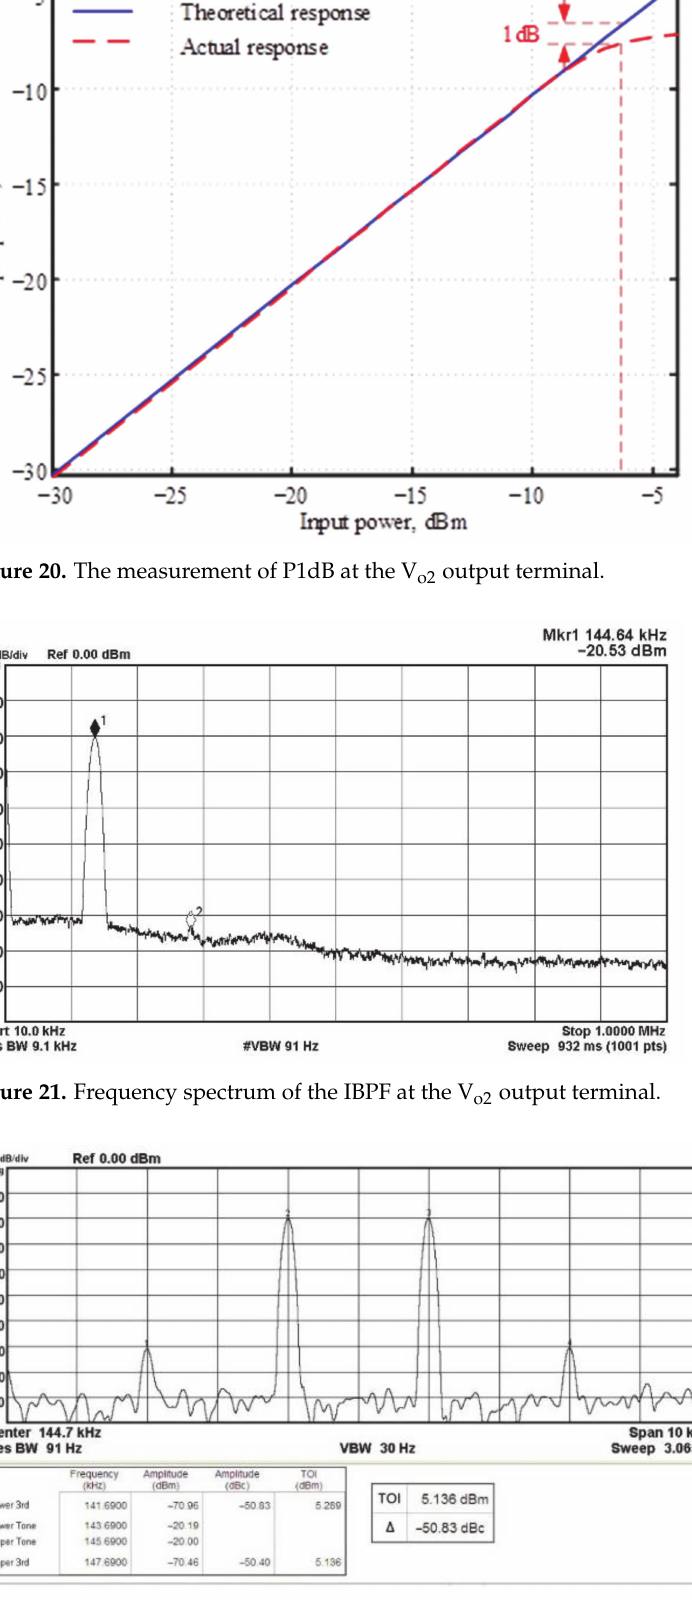
Figure 22. The IBPF output spectrum of V o2 for a two-tone -IMD